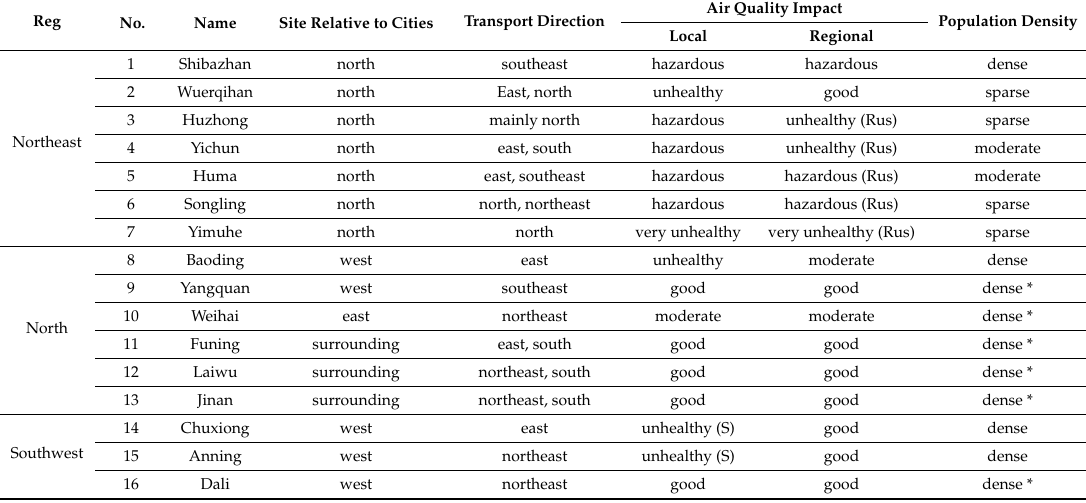
Figure 10. Same as Figure 3 except for the Chuxiong fire. Panels ( a – d ) are 26–29 April 2013, respectively. Table 2. Smoke transport and air quality impacts. S and Rus in parenthesis represent sensitive groups and Russia, respectively. The population density is the population density classification of the areas in China where smoke PM 2.5 concentrations reached the level of unhealthy to sensitive groups or